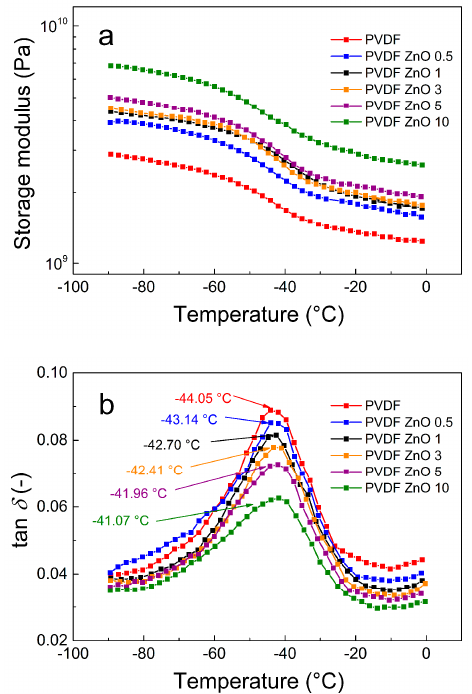
Figure 8. Temperature dependence of the storage modulus ( a ) and tan δ ( b ) for neat PVDF and the PVDF ZnO star-like composite films with various filler contents.